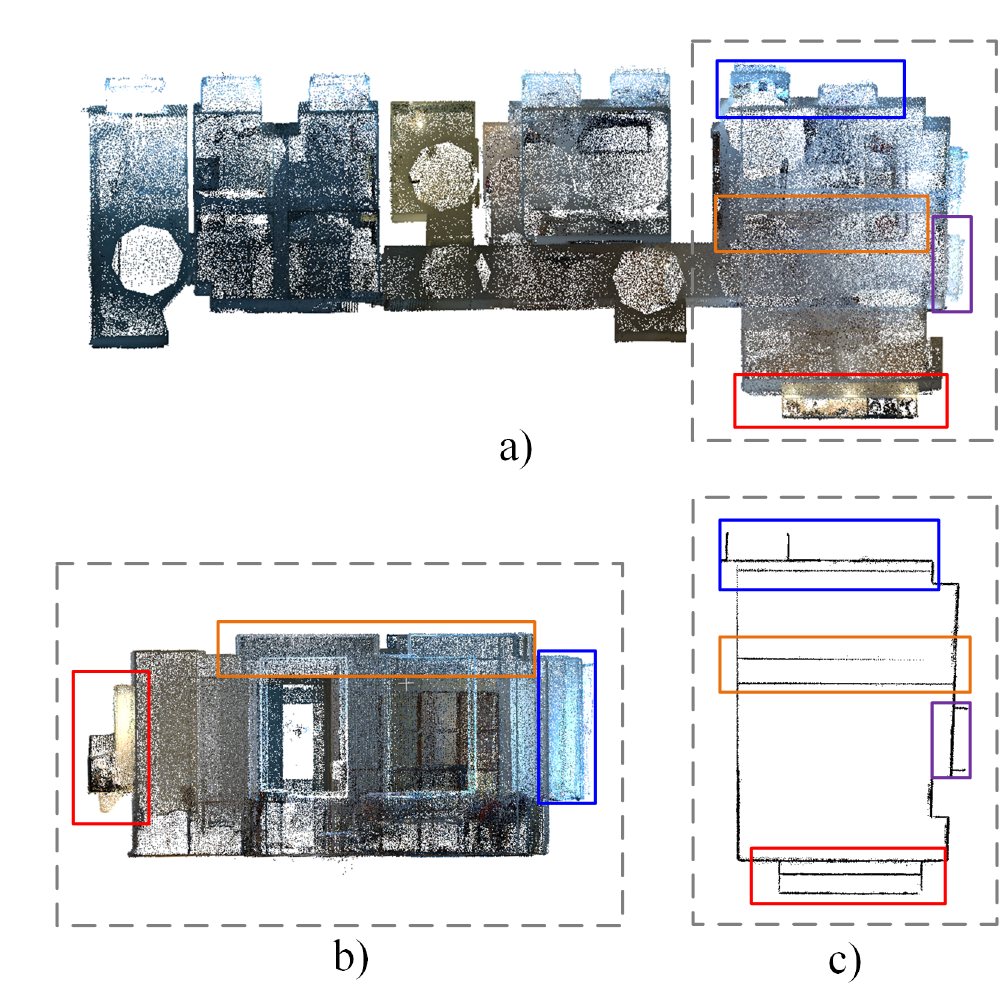
Figure 1. Multiple views of point clouds: ( a ) Top-down view of filtered point clouds. ( b ) Side-view of filtered point clouds. ( c ) The 2D projection of point clouds (the rectangles with different colors denote the corresponding structures in multi-view